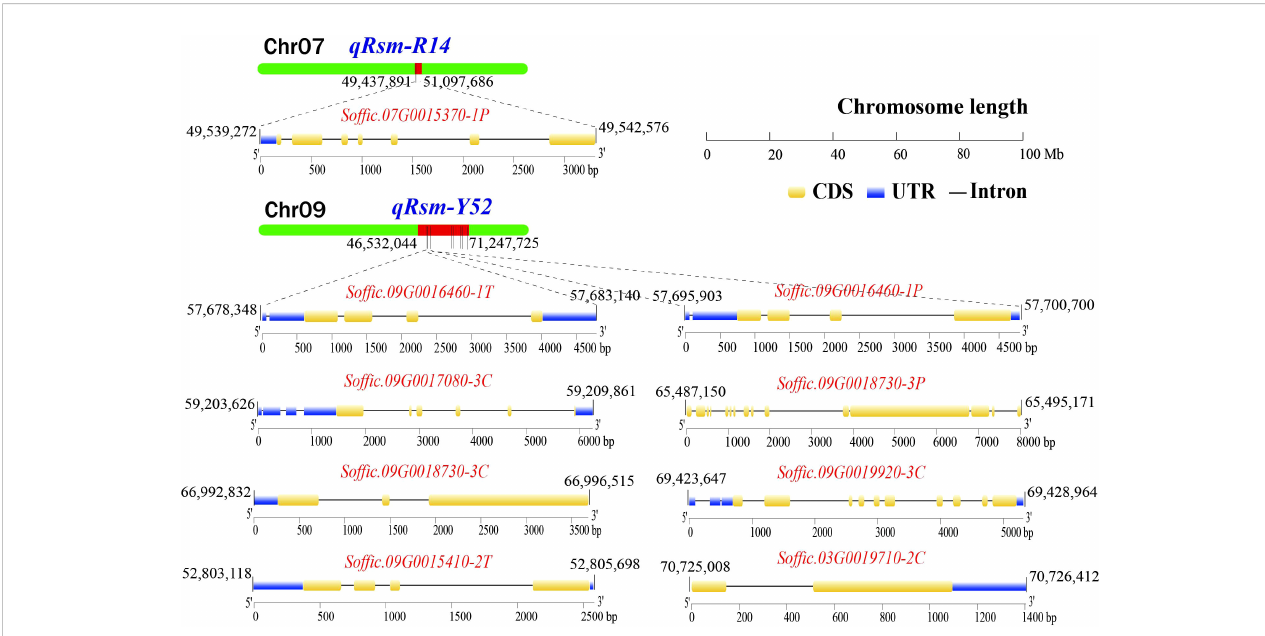
FIGURE 6 The genomic location, conserved domain, and gene structure of SMD resistance-related candidate key genes (UTR, untranslated region; CDS, coding